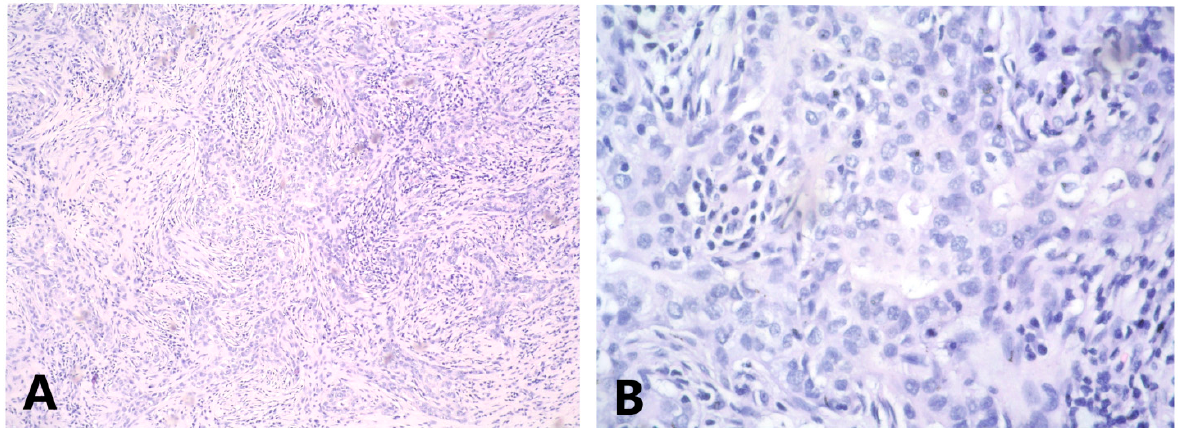
Figure 5. ( A ) Invasive NST ductal carcinoma G3 with prominent stromal lymphocytic infiltration HE 4x; ( B ) high power magnification of the tumor with predominantly nested growth; nuclei are high to moderately pleomorphic HE 40x.